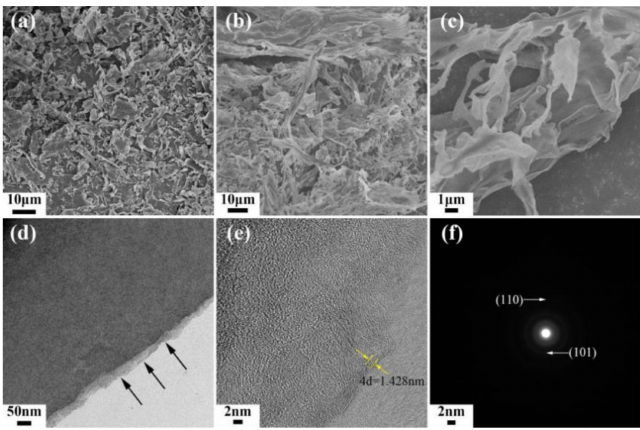
Figure 3. SEM images of the precursor ( a ) and the BN product ( b , c ); ( d ) TEM images of the BN product; ( e ) HRTEM; and ( f ) the SAED pattern.